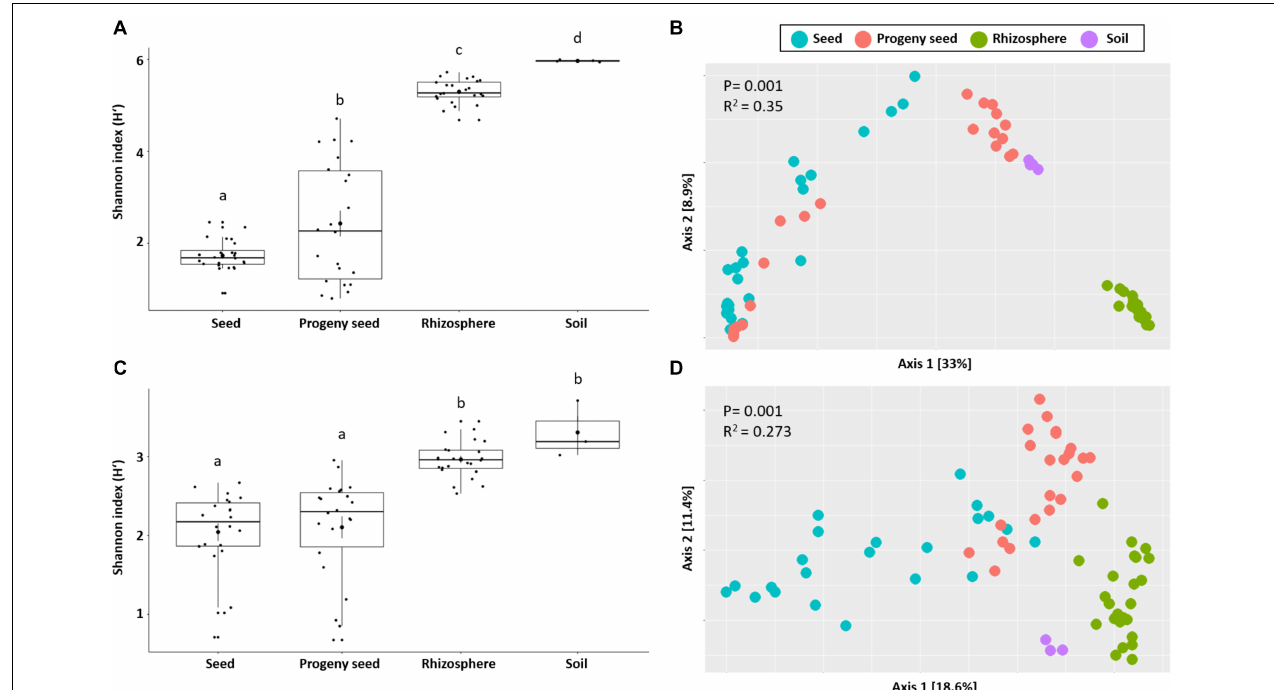
FIGURE 1 | Observed bacterial (A,B) and fungal (C,D) diversity in samples. Shannon index (alpha diversity) as well as beta diversity obtained by Bray–Curtis distance matrix is shown. Significant differences are indicated by different letters as well as given p -values.